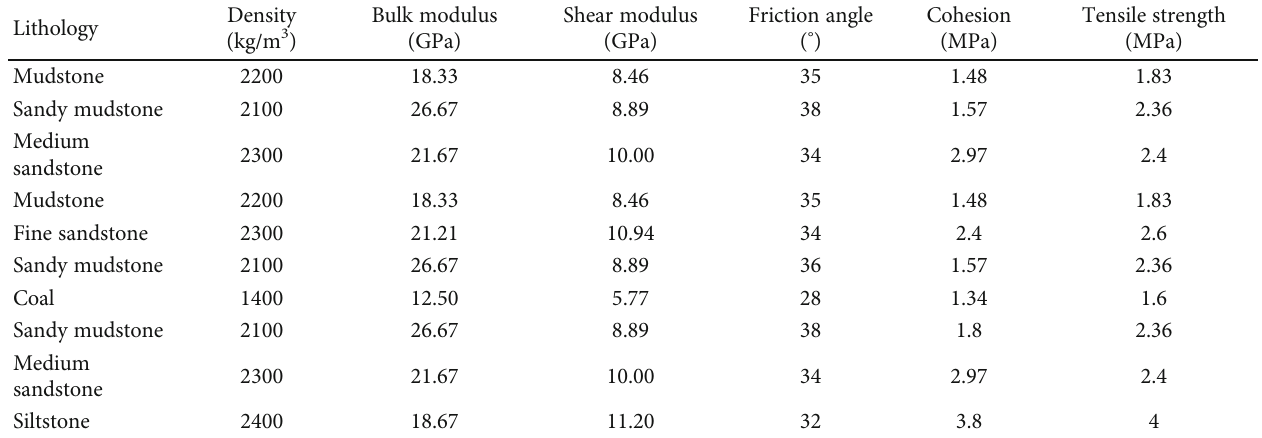
Table 1: Numerical analysis of physical and mechanical parameters of coal rock stratum.